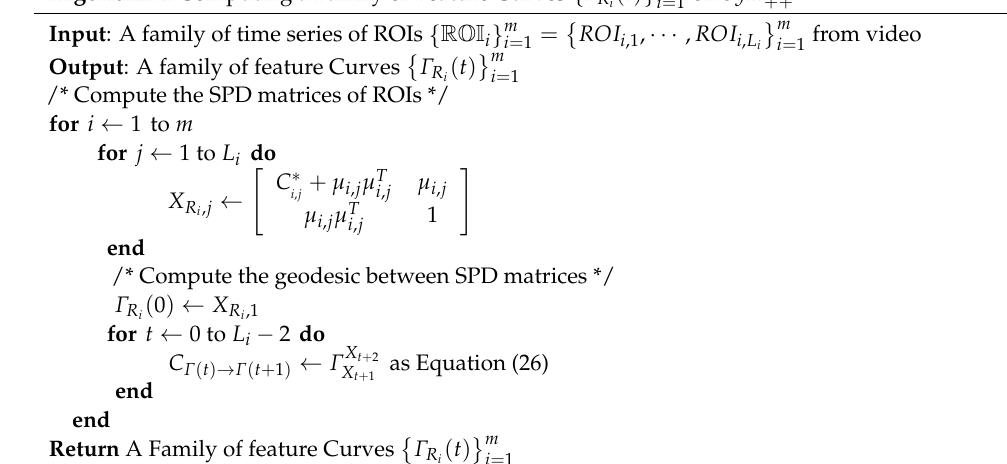
Algorithm 1 Computing a Family of Feature Curves